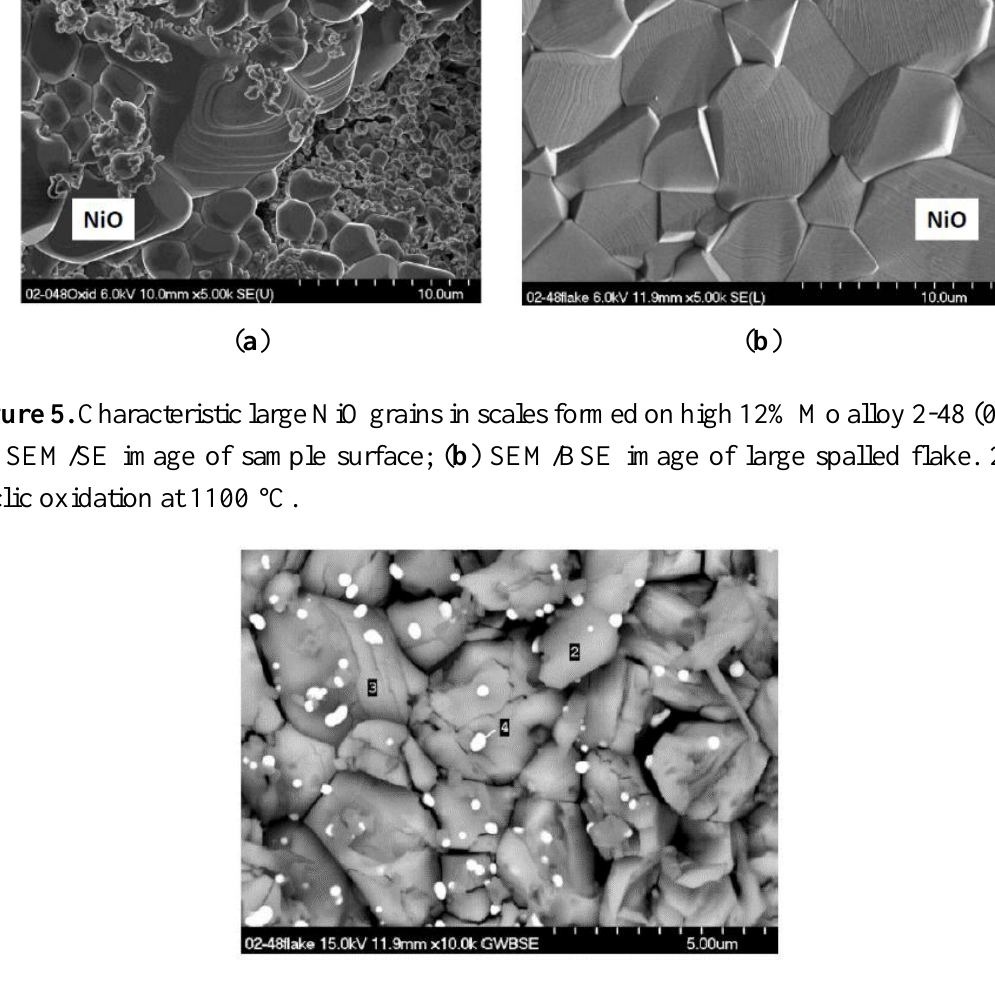
Figure 6. Micro-laminated high Mo oxide grains underlying Ta-rich spheroids. Spalled flake from high 12% Mo (0010) alloy 2-48 after 200 h cyclic oxidation at 1100